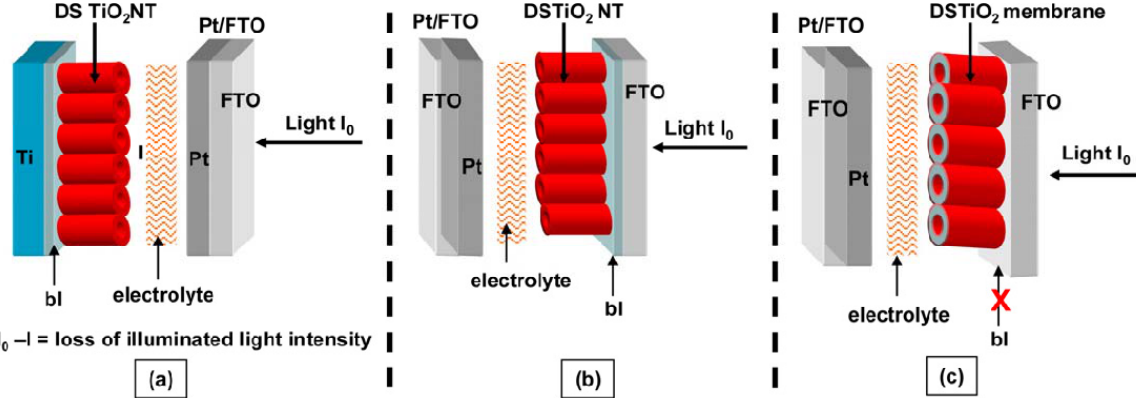
nanotubes. “bl” represents the Figure 12. Different orientations of DSSCs with TiO 2 barrier layer of TiO at the closed ends of the nanotubes. ( a ) Backside illumination with 2 nanotubes on titanium foil; ( b ) Front-side illumination with nanotubes on fluorine-doped tin oxide coated glass (FTO glass); ( c ) Frontside illumination with nanotubes open on both ends. Reprinted with permission from [31]. Copyright 2010 IOP